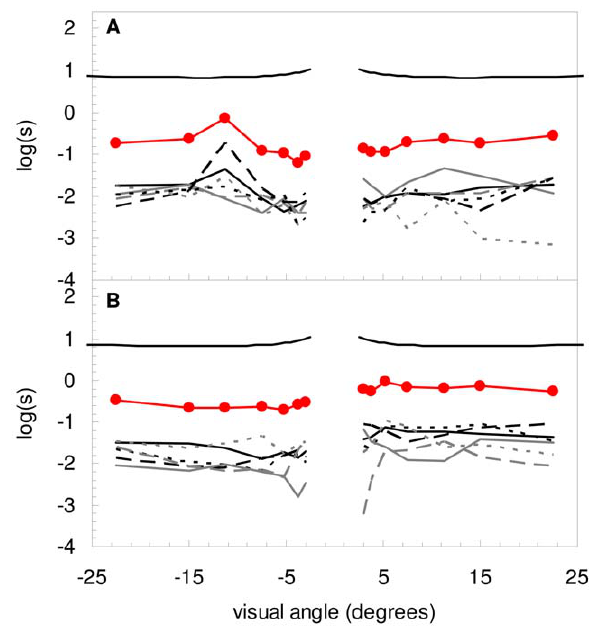
Figure 4. PSF of 6 individual pits (bottom 6 curves in each figure) for the IOL of a) figure 2a and b) figure 2b. The line with closed circle symbols represents the estimated total contribution of all pits in the IOL. The top PSF illustrates the PSF-model, according to the CIE, of a 35–year-old individual.